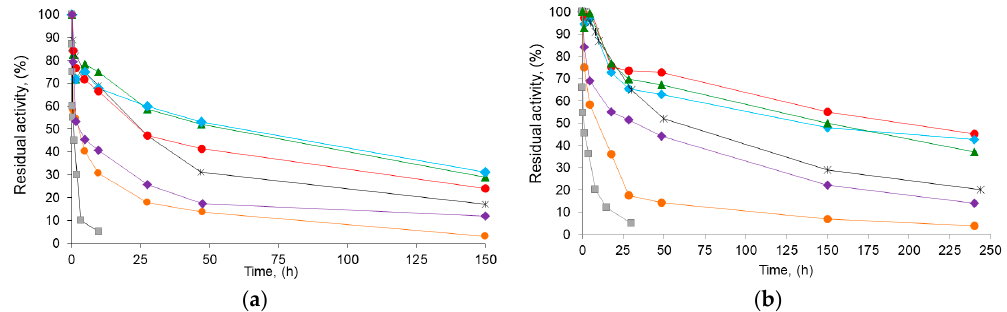
Figure 6. Time course inactivation of BTL2 biocatalysts: ( a ) inactivation at 75 ° C, pH 7.0, and ( b ) in the presence of 80% ( v / v ) dioxane, 30 °C, and pH 7.0. CNBr-derivative of BTL2 ( ■ ) and glyoxyl derivatives of chemically aminated BTL2 immobilized with DTT: at pH 7.0 and incubated at pH 7.0